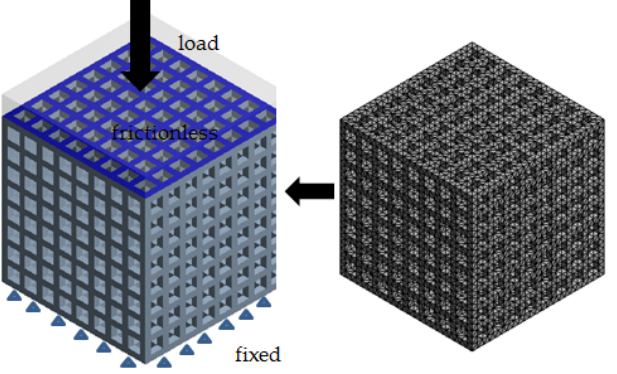
Figure 2. The finite element model of the honeycomb structure.